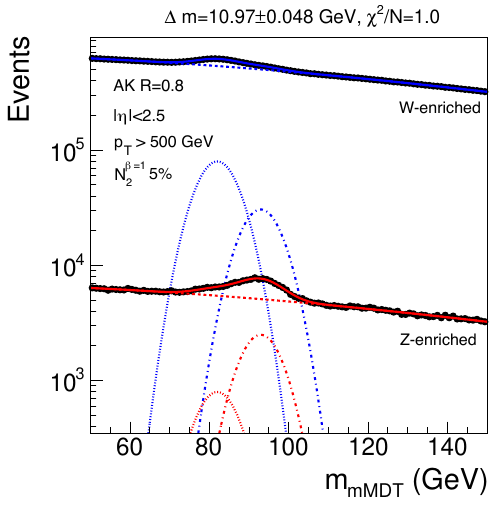
Figure 5 . Simultaneous (cid:12)t of the W + Z signal shape plus the functional form parametrizing the background to two distributions of the mass m mMDT of the leading jet in the Z -enriched and W - enriched event categories from simulated signal and background pseudo-data corresponding to an integrated luminosity of 3000/fb. The (cid:12)tted value of the mass di(cid:11)erence between the Z peak and the W peak (cid:1) m = m Z (cid:0) m W and its statistical uncertainty is quoted on top of the (cid:12)gure together with the (cid:31) 2 per degree of freedom, N , of the (cid:12)t.